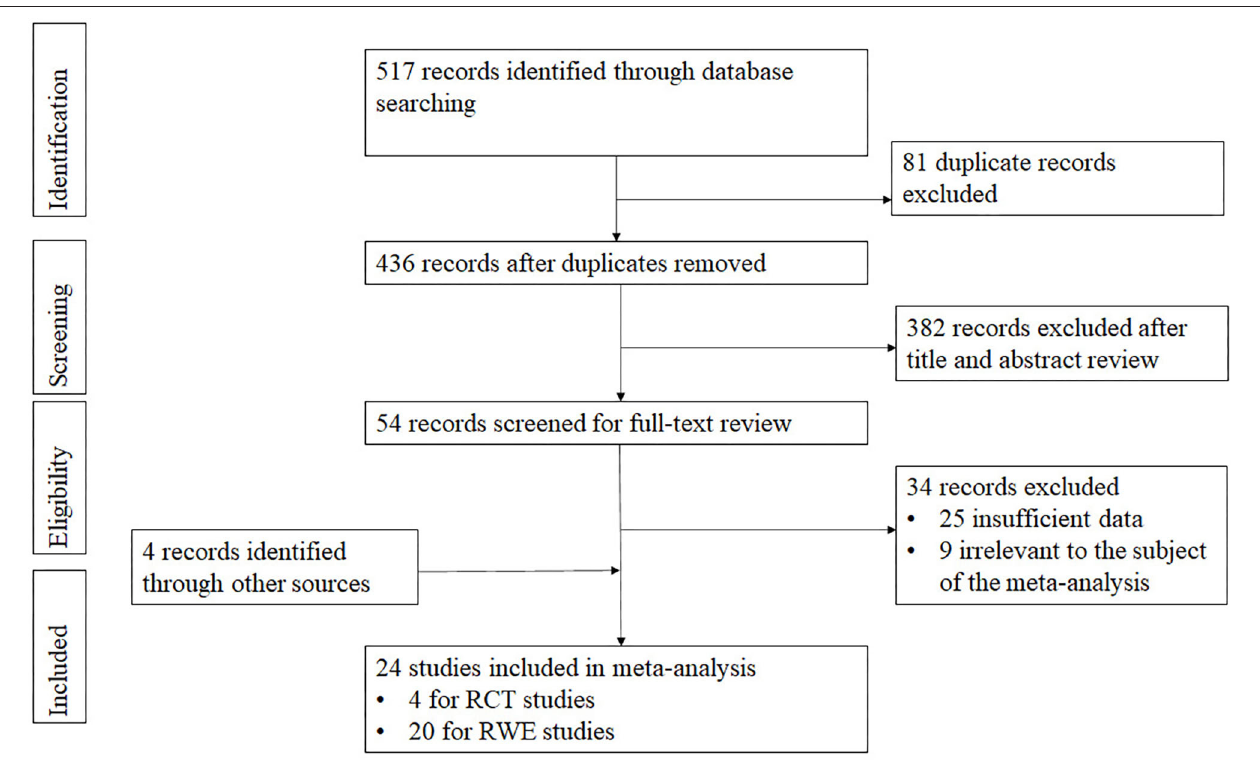
FIGURE 2 | PRISMA flowchart for review of the study